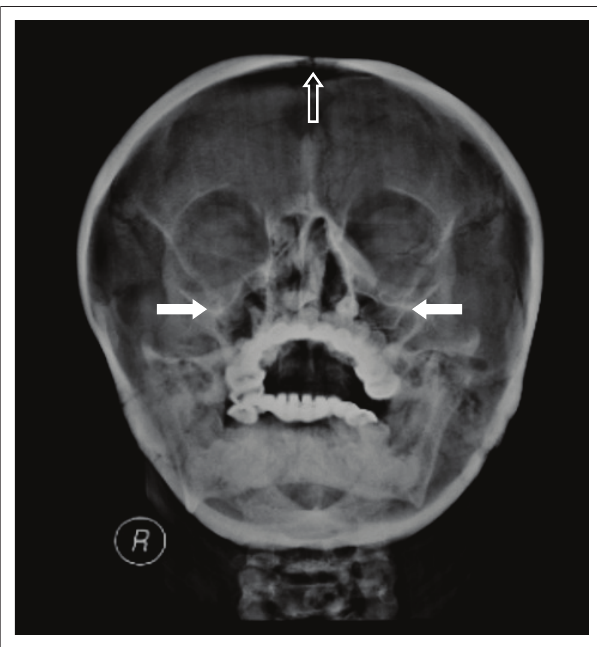
FIGURE 2: Water’s view for paranasal sinuses shows an open metopic suture (hollow arrow), aplastic frontal sinuses, hypoplastic maxillary sinuses (white arrows) and underpneumatised mastoids.